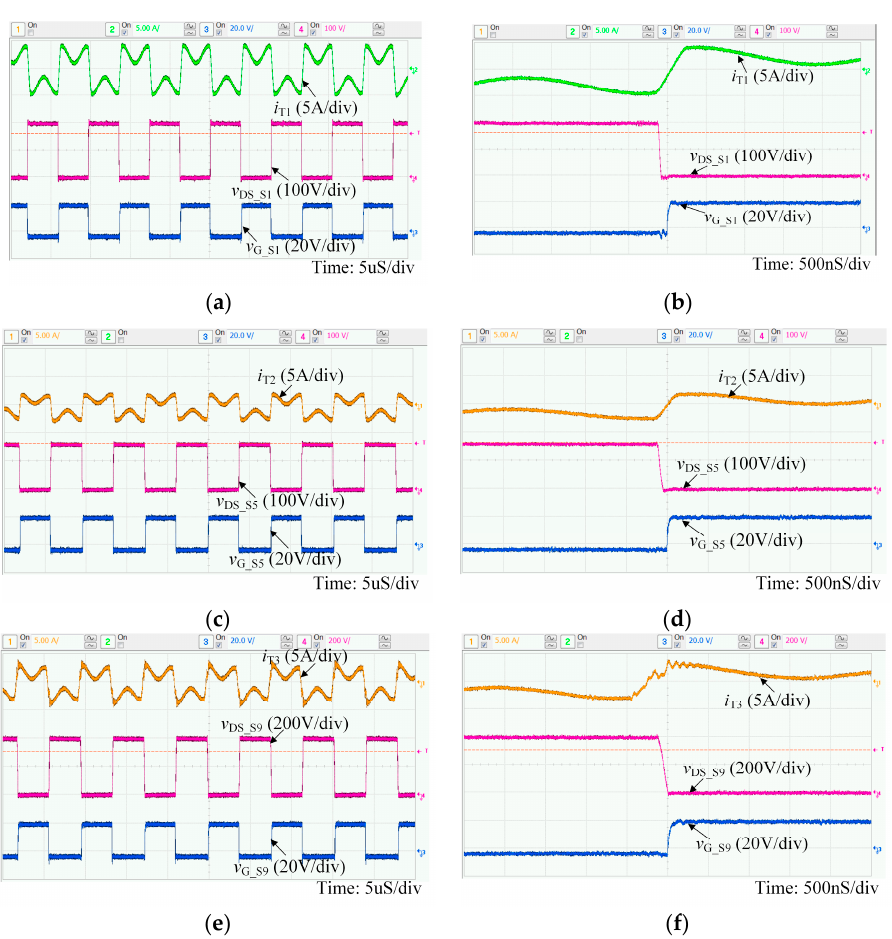
Figure 14. Experimental results of MR-TP-BDC under forward half load operating mode: ( a , b ) port 1; ( c , d ) port 2; ( e , f ) port 3.